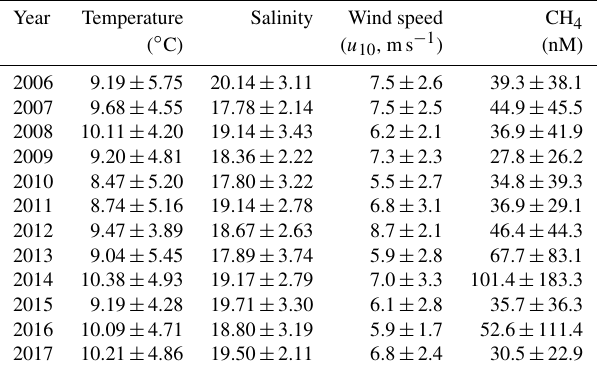
Table 1. Annual mean (arithmetic average ± standard deviation) of water temperature, salinity, wind speed and dissolved CH 4 concen- trations at BE during 2006–2017. Water temperatures, salinity and CH 4 concentrations were averaged over the water column (0–25m). Wind speeds were recorded at Kiel